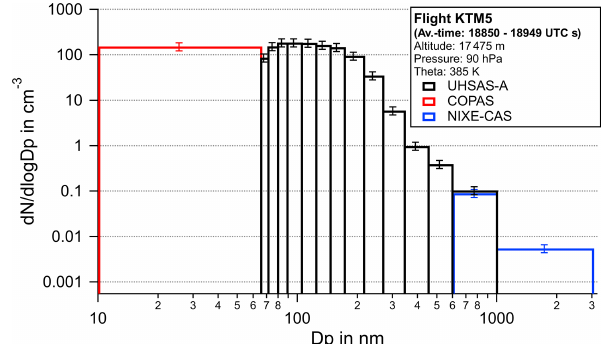
Figure 6. Aerosol particle size distribution measured within the ATAL during flight KTM5 of the 2017 StratoClim measurement campaign. Combined out of the measurements conducted by the COPAS (red size bin), the UHSAS-A (black size bins), and the NIXE-CAS (blue size